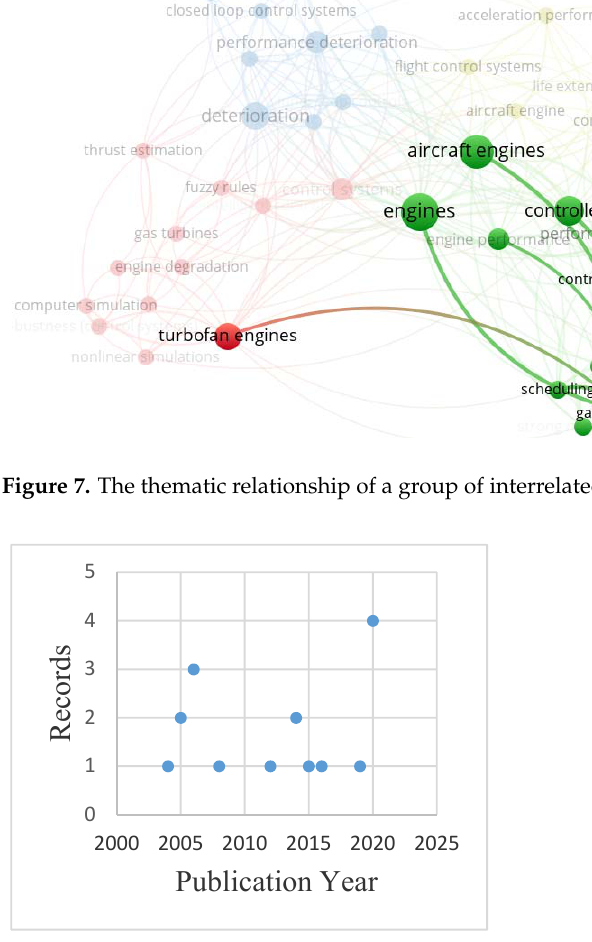
Figure 9. List of the top five countries in terms of published articles.